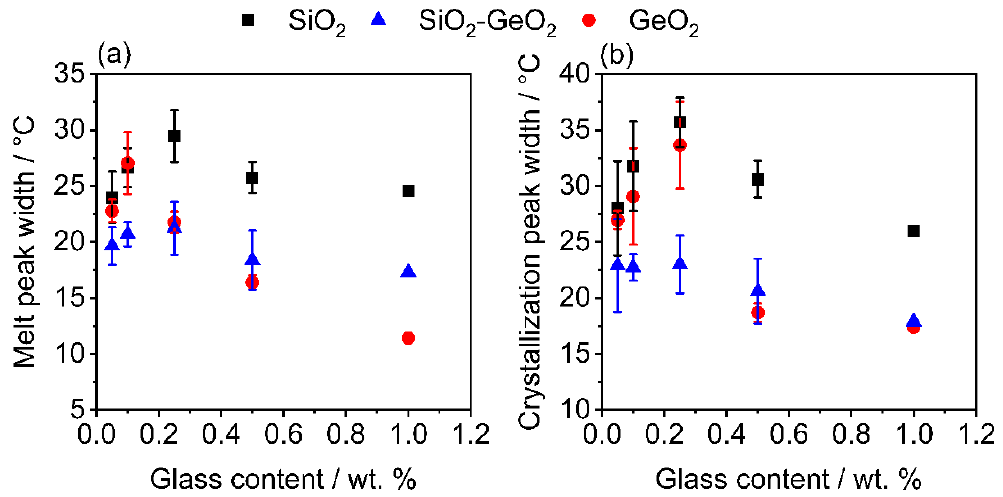
Figure 12. Change in peak width of the different blends; ( a ) melt peak width; ( b ) crystallization peak width.